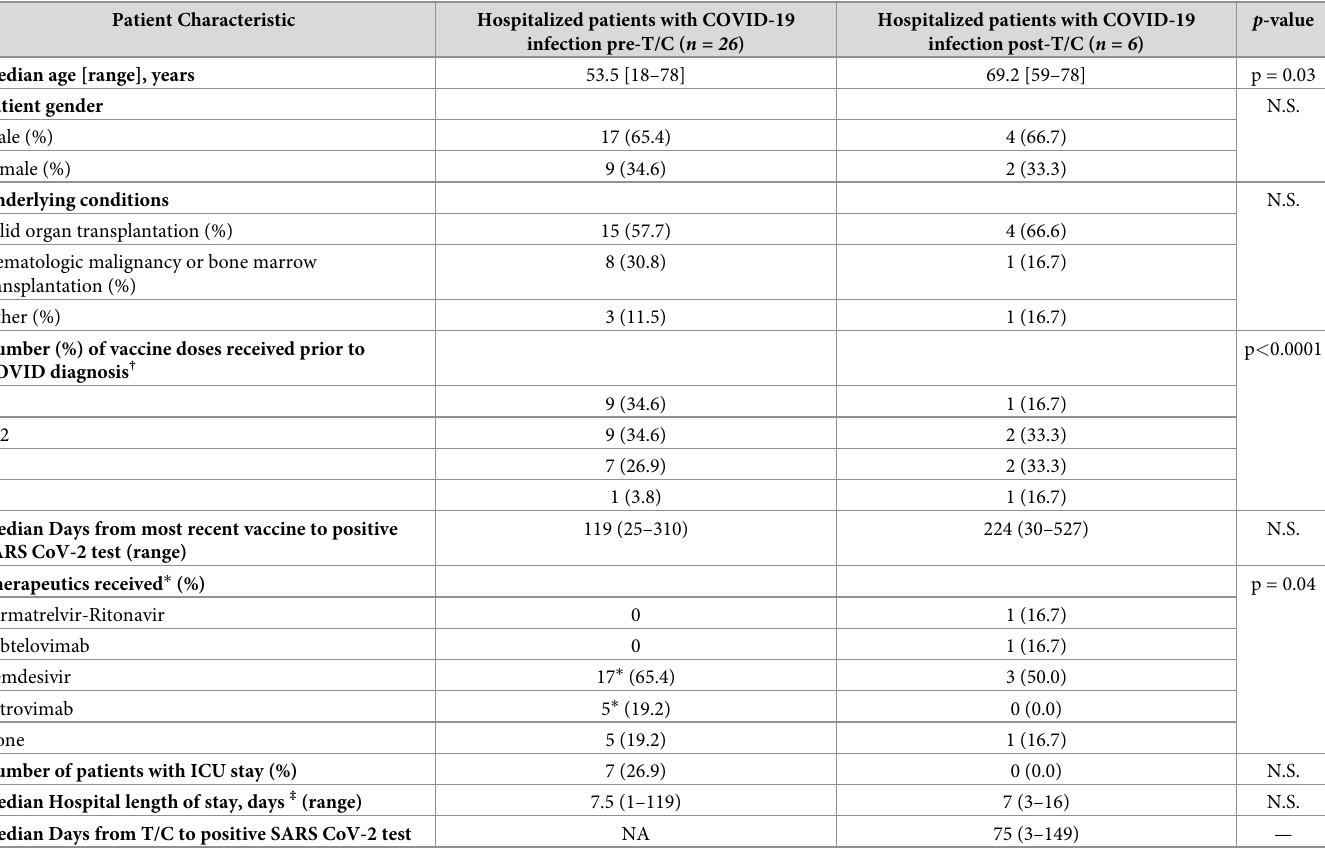
Table 2. Characteristics of patients hospitalized with COVID-19 infection before and after receipt of